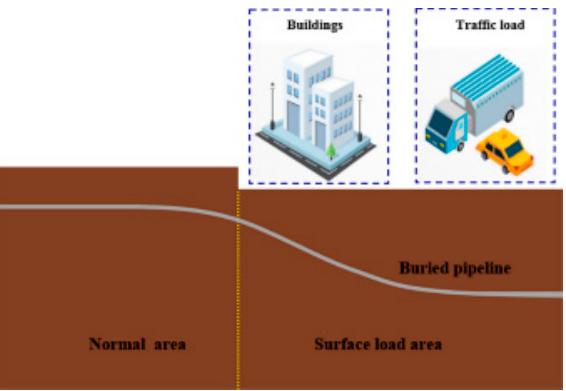
Figure 1. Schematic illustration of urban gas pipeline under surface load.